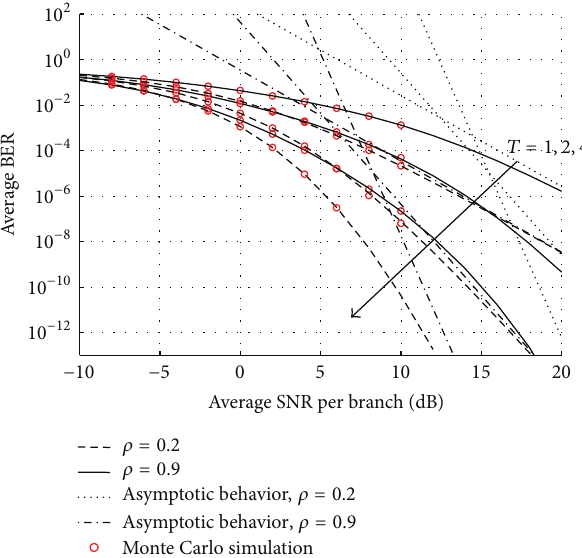
Figure 4: Average BER versus average SNR per receive antenna with BPSK modulation for 𝑇 = 1, 2,4 , 𝑅 = 4 and constant correlation with 𝜌 = 0.2, 0.9 . Simulation points and asymptotic behavior are also shown.